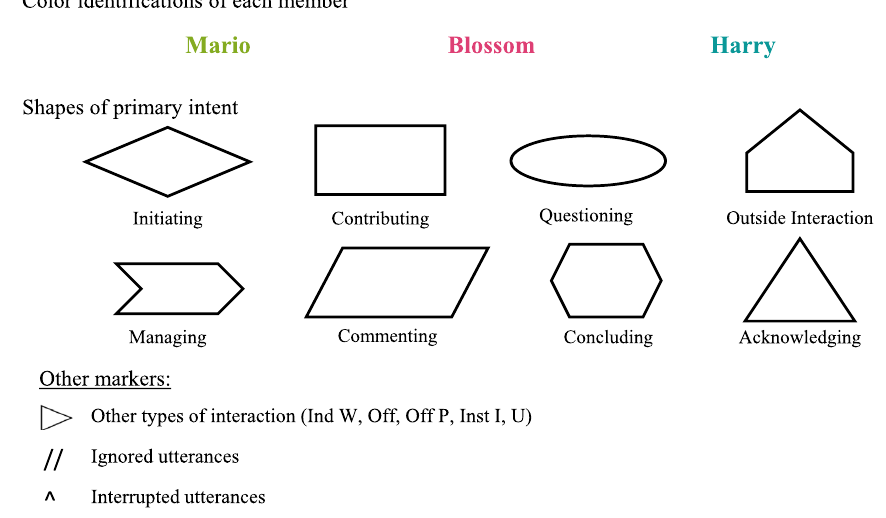
Fig. 2 Key of colors, symbols, and markers used to construct the discourse